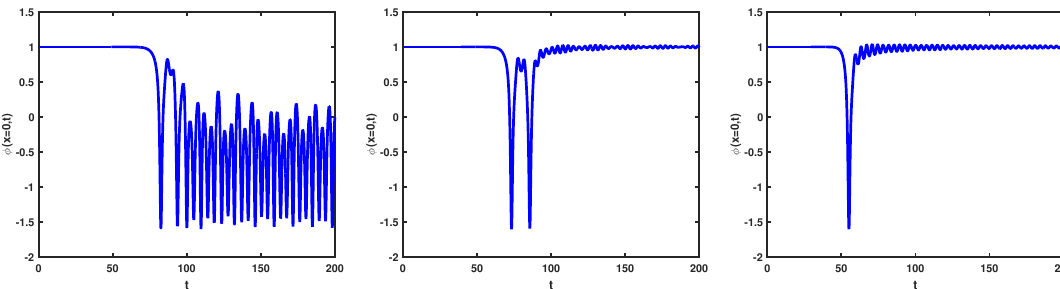
Figure 1 . Kink-antikink collisions for the (cid:30) 4 model, corresponding to (cid:15) = 0. Scalar (cid:12)eld at the center of mass, (cid:30) (0 ; t ), showing a) the formation of bion state (for v = 0 : 17), b) two-bounce collision (for v = 0 : 1926) and c) one-bounce collision (for v = 0 :